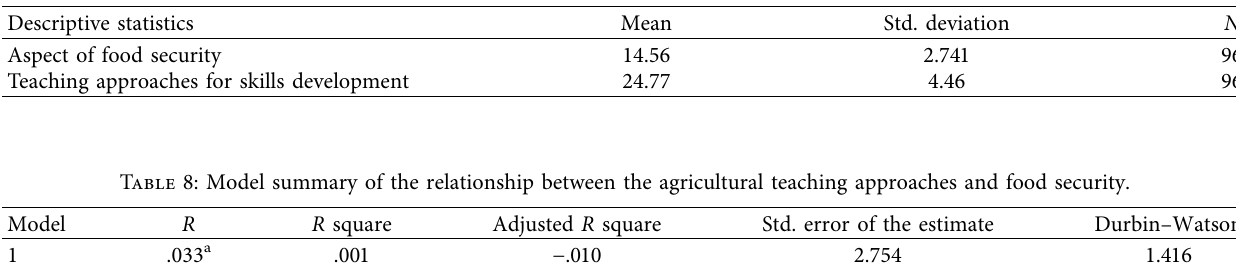
Table 7: Mean and standard deviation.